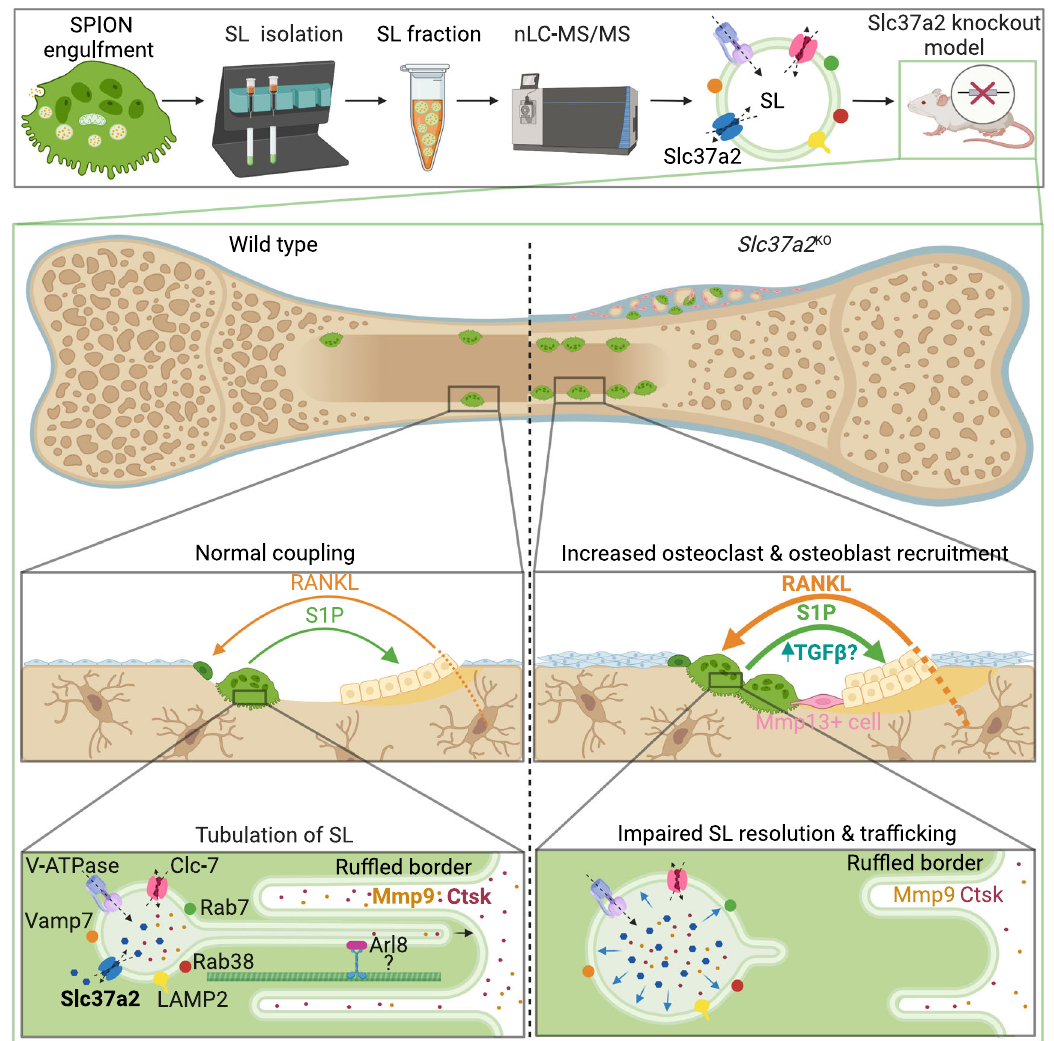
Fig.10|WorkingmodelofSlc37a2inosteoclastfunctionandbonemetabolism. Top panel provides an overview of proteomic identi fi cation of sugar transporter Slc37a2on osteoclast secretorylysosomes, the middle panels highlight tissue level alterations in osteoclast – osteoblast coupling during bone remodeling in Slc37a2 -